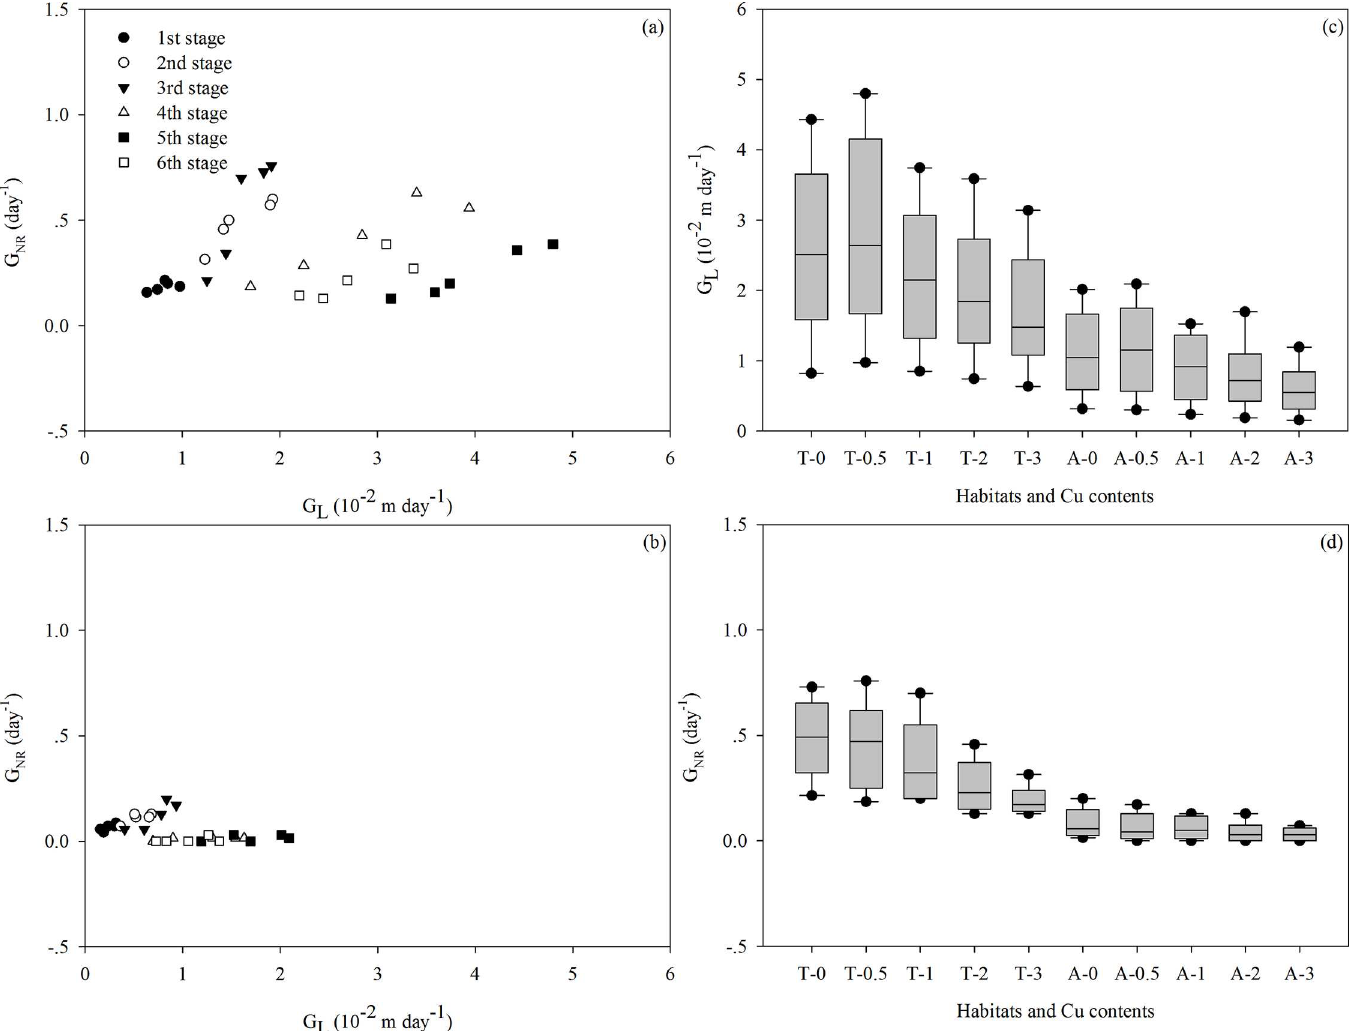
Fig 3. Growth rate of the total length (G L ) and growth rate of new ramets (G NR ) of Alternantheraphiloxeroides in terrestrial habitats (a) and aquatic habitats (b) across six stages. The box-plot graphs show the variation in G L (c) and G NB (d) of the plants in terrestrial habitats (T) and aquatic habitats (A) under different Cu pollution,and the data for the stages are